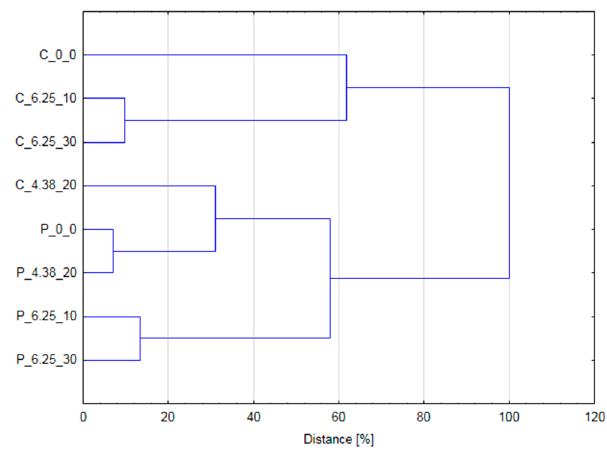
Figure 4. The results of hierarchical cluster analysis (HCA) performed using color parameters (L*, a*, b*) and concentration of betanin and vulgaxanthin. (C_0_0 = untreated beetroot cylinders; C_4.38_20 = beetroot cylinders treated by 20 pulses at 4.38 kV/cm; C_6.25_10 = beetroot cylinders treated by 10 pulses at 6.25 kV/cm; C_6.25_30 = beetroot cylinders treated by 30 pulses at 6.25 kV/cm; P_0_0 = untreated beetroot pulp; P_4.38_20 = beetroot pulp treated by 20 pulses at 4.38 kV/cm; P_6.25_10 = beetroot pulp treated by 10 pulses at 6.25 kV/cm; P_6.25_30 = beetroot pulp treated by 30 pulses at 6.25 kV/cm). Table 4. The results of Pearson’s correlation analysis.